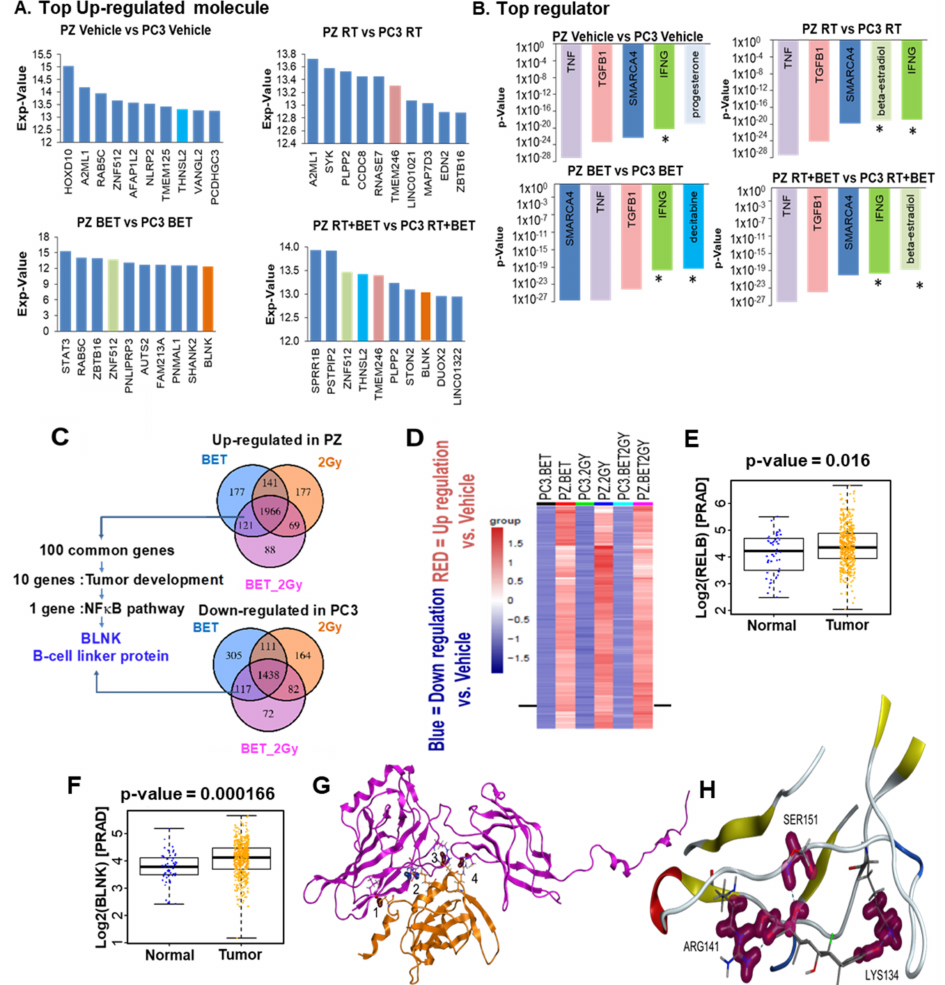
Figure 5. RNA sequencing identifies BLNK as a novel complementary protein that is upregulated by BET-mediated RelB expression. ( A ) Upregulated molecules that were most significantly changed (threshold exp-value 10). The rank order is determined by the indicated p -values. ( B ) 5 regulator pathways that were most significantly changed (threshold p -value 1.3). All these top regulators contain NF-kB family, and regulator star (*) contains BLNK. ( C ) Venn diagrams identified BLNK as the one of the proteins that is upregulated in PZ cells and downregulated in PC3 cells. ( D ) Heat map demonstrated ~2000 common genes that are diversely expressed in PC3 and PZ cells by all the treatments. Red = Upregulation vs. vehicle; Blue = Downregulation vs. vehicle, in PZ vs. PC3 cells. ( E ) RelB and ( F ) BLNK in PCa ( n = 499) vs. normal prostate ( n = 52) from TCGA database vs. vehicle. PARD = Prostate Adenocarcinoma. RELB and BLNK expressions are presented in log2-transformed transcripts per kilobase million (TPM) values. p -value calculated from linear mixed model. ( G ) PPI between RELB (magenta) and BLNK (orange). Contacts (1–4) given following: (1) Hydrogen bond at Cys 343 (BLNK) and Leu127 (RelB); (2) Ionic bond at Arg427 (BLNK) and Glu290 (RelB); (3) Hydrogen bond at His431 (BLNK) and Arg136 (RelB); and (4) Hydrogen bond at Arg448 (BLNK) and Cys389 (RelB). ( H ) Docking and binding analysis with ZDOCK and PyMol suggesting the interaction at the Y300 residue of RelB and the conserved R32 and R51 residues of